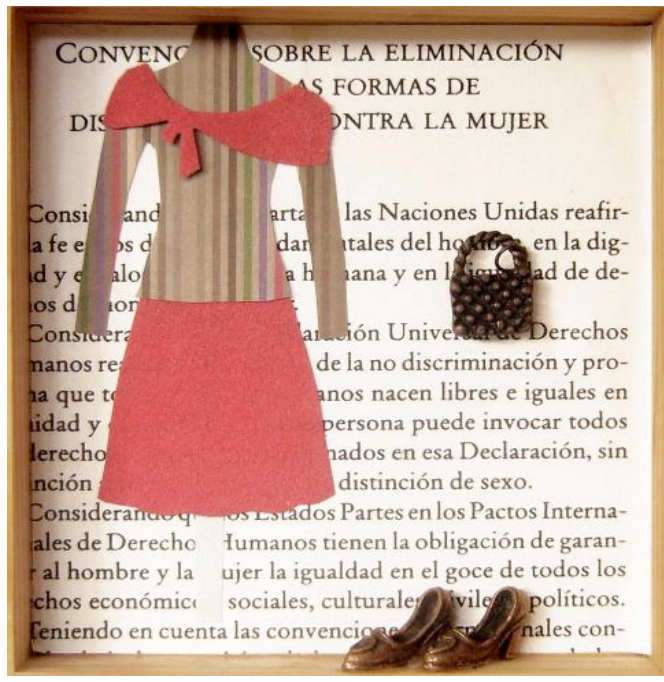
Figure 5. Gaviria, Shadow Box, 2008. Image provided by the artist.